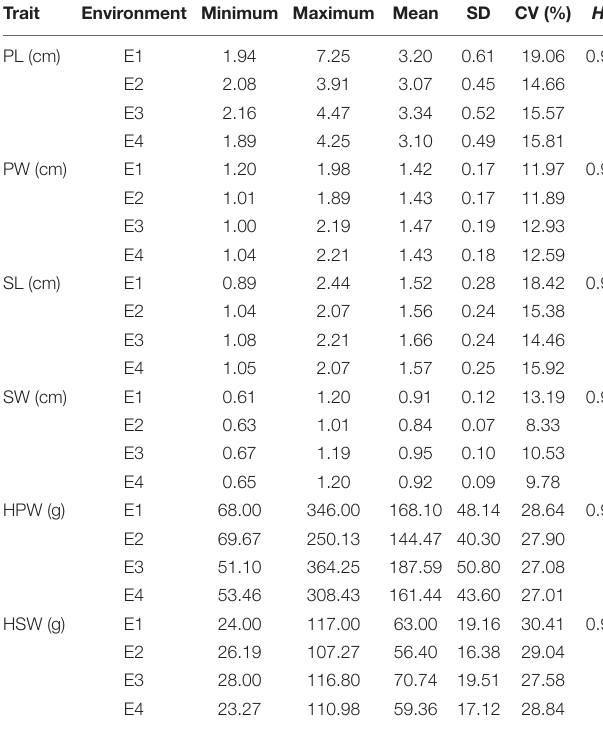
TABLE 1 | Phenotypic performance of the six yield-related traits in the Chinese peanut mini-core collection under four